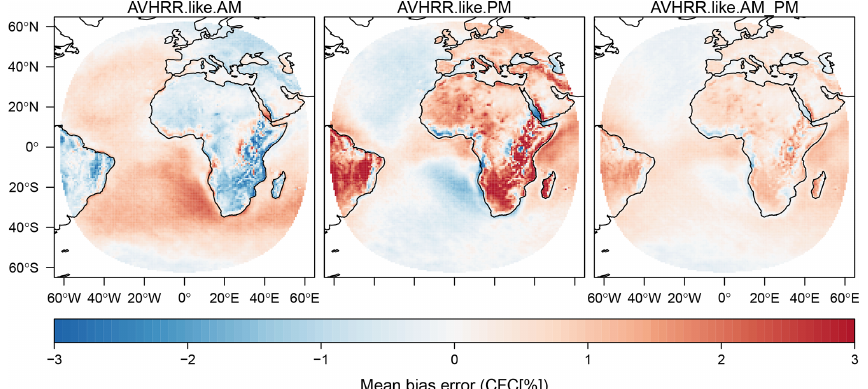
Figure 13. The mean bias error caused by orbital drift and discrete sampling of CFC diurnal cycle presented for AVHRR-like CDRs derived from morning (AM), afternoon (PM), and combined (AM_PM)